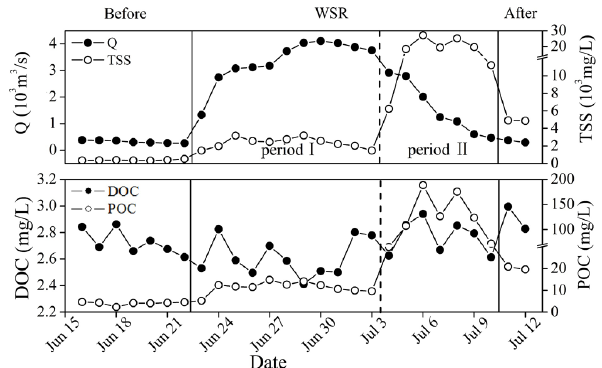
Fig. 4. Distributions of discharge ( Q ), TSS, POC, and DOC before, during, and after the 2008 water and sediment regulation (WSR) pe- riod at the Lijin station. Period I stands for the water release period and period II denotes the sediment release